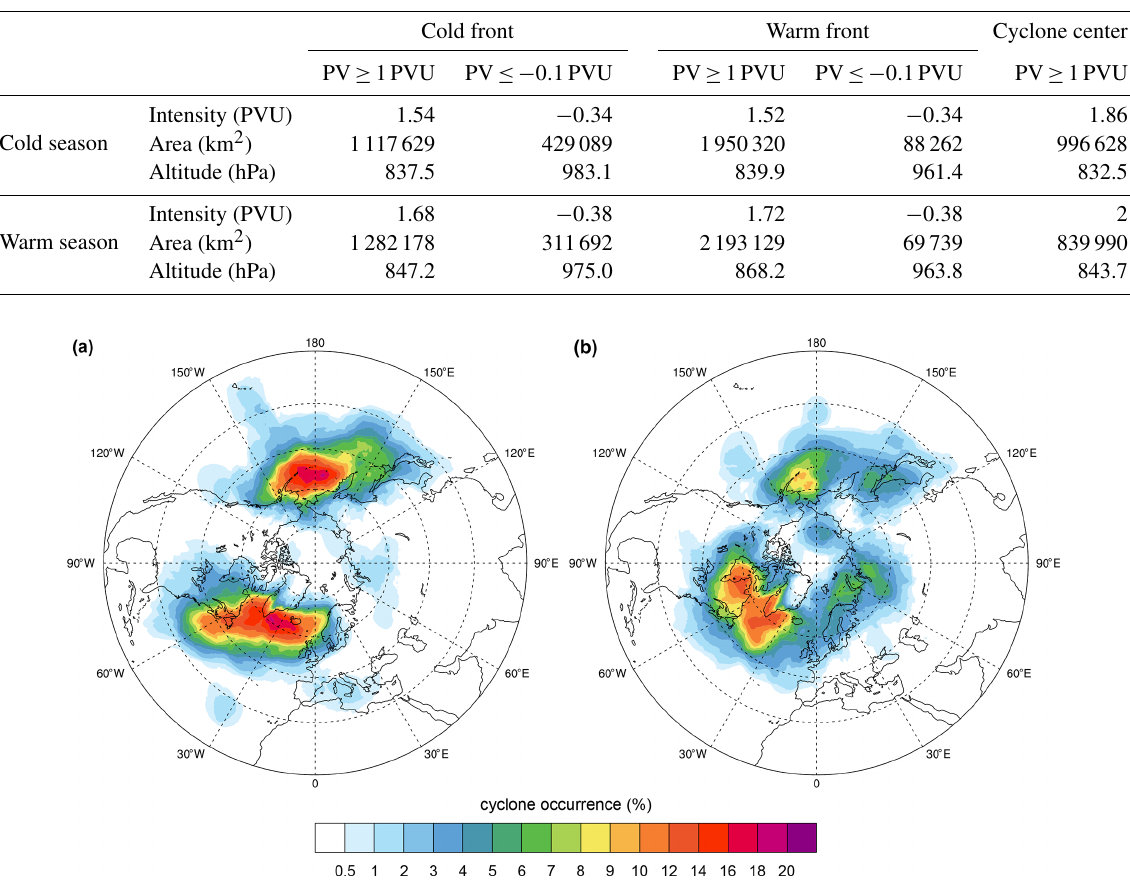
Figure 1. Geographical distribution of extratropical cyclones considered in this study for (a) the cold season and (b) the warm season. Percentages depict the fraction of time steps with a cyclone present; i.e., 10% corresponds to roughly